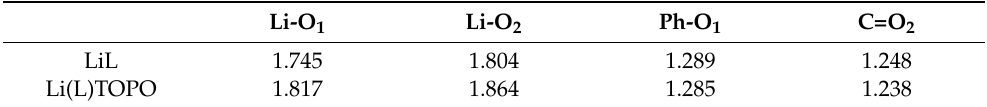
Table 5. Binding lengths values di (Å) and angles ( ◦ ) in six-membered metallacycles LiL and Li(L)TOPO. Li-O 1 Li-O 2 Ph-O 1 C=O 2 LiL 1.745 1.804 1.289 1.248 Li(L)TOPO 1.817 1.864 1.285